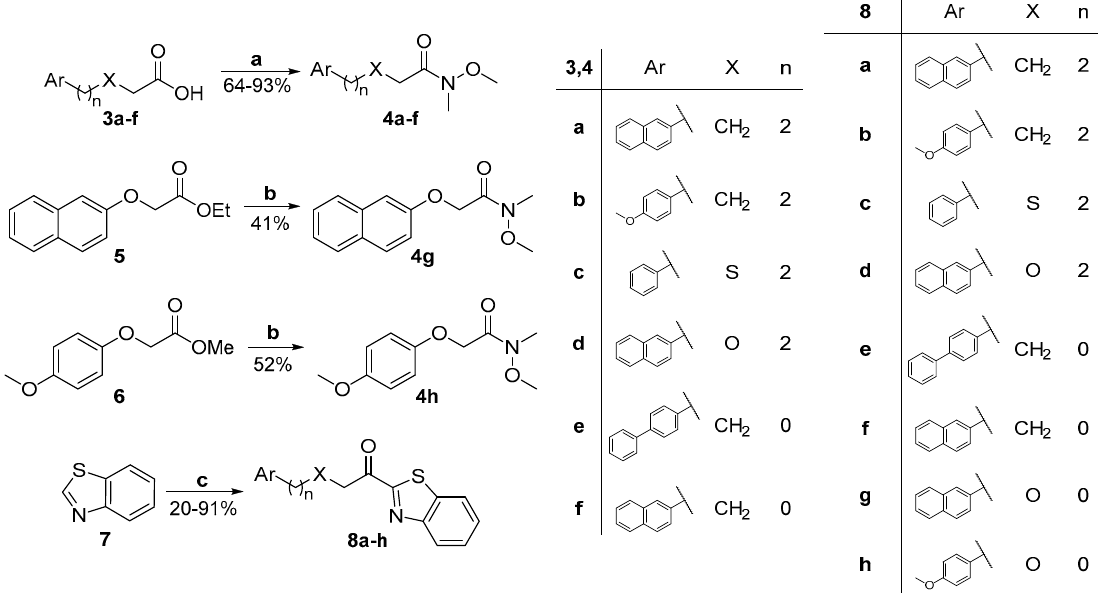
Figure 3. Synthesis of α -ketobenzothiazoles 8a – h . ( a ) HN(OMe)Me·HCl, WSCI·HCl, DMAP, NMM, CH 2 Cl 2 ; ( b ) (i) HN(OMe)Me·HCl, dry THF, − 20 °C; (ii) i -PrMgCl, -20 °C; and ( c ) (i) n -BuLi, dry Et 2 O, − 78 °C; (ii) Weinreb amides 4a – h , dry Et 2 O, − 78 °C to rt.